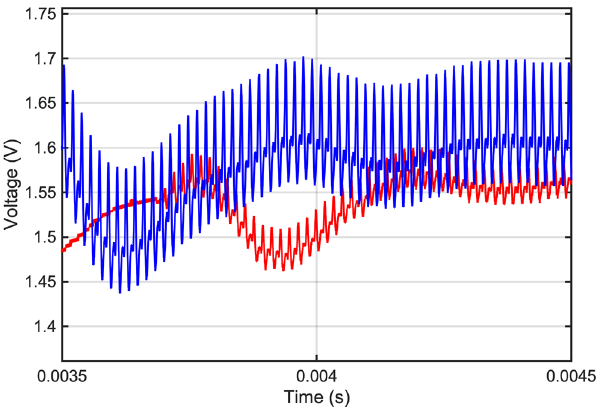
Figure 5. Zoom of the peculiar phenomenon occurring at the minima and maxima of the mains voltage waveform for the LW SMPS (see Figure 4a).